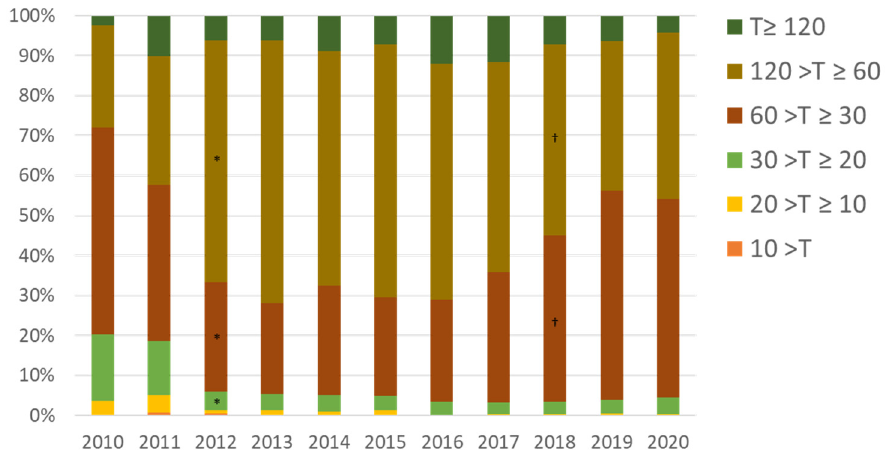
Figure 7. Changes in proportion of time to hospital arrival by ambulance before and after the 2011 Fukushima accident. T is in minutes. * p < 0.001 vs. 2010; † p < 0.001 vs. 2017. The proportion taking 60 to 120 minutes increased after the accident (*), but decreased after the Futaba Medical Center was established in 2018 (†).